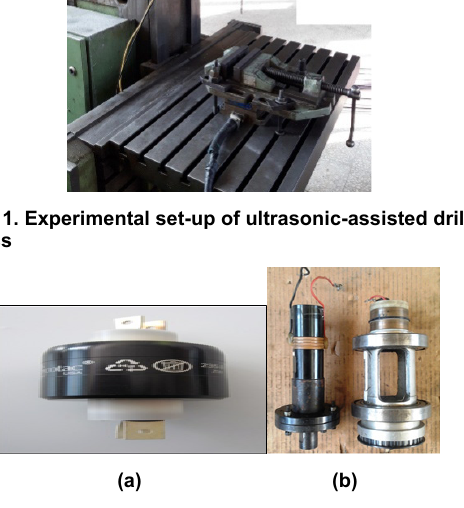
Figure 2. (a) Ultrasonic transducer with rotating frame; (b) Slipping ring